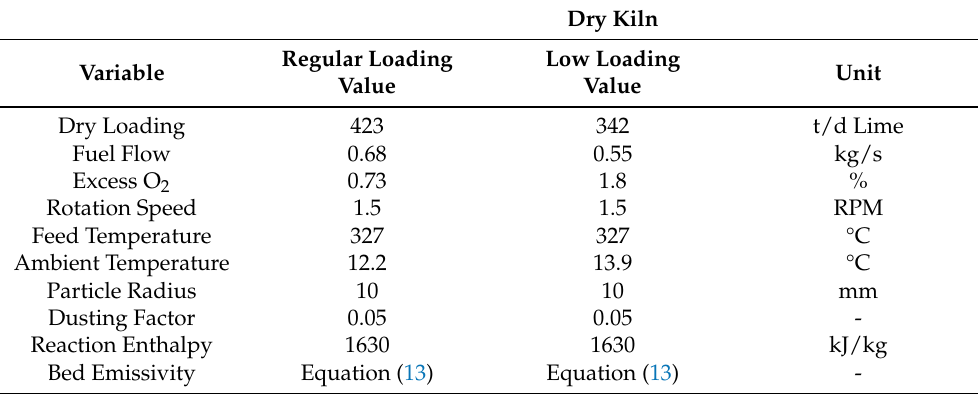
Table 4. Dry kiln baseline